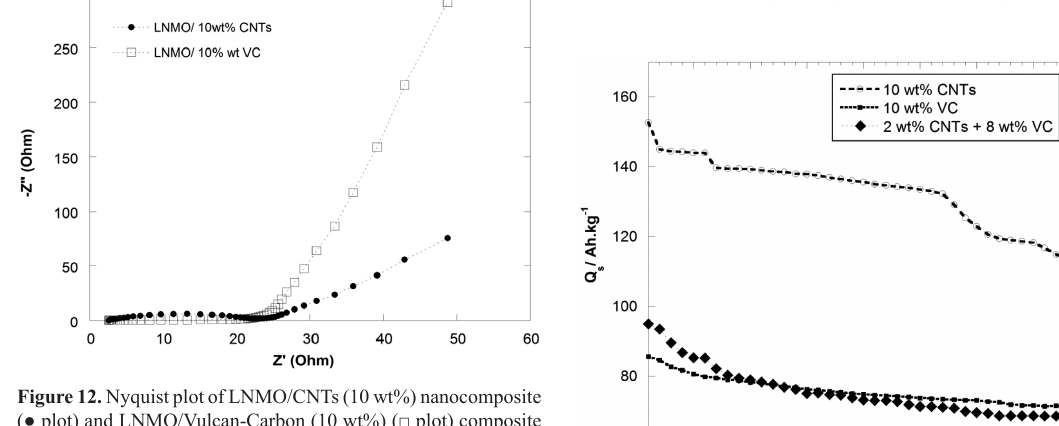
Figure 14. 1 st charge discharge cycle at C/10 rate of nanocomposites electrodes: LNMO/VC (10 wt%) and LNMO/CNTs (10 wt%).